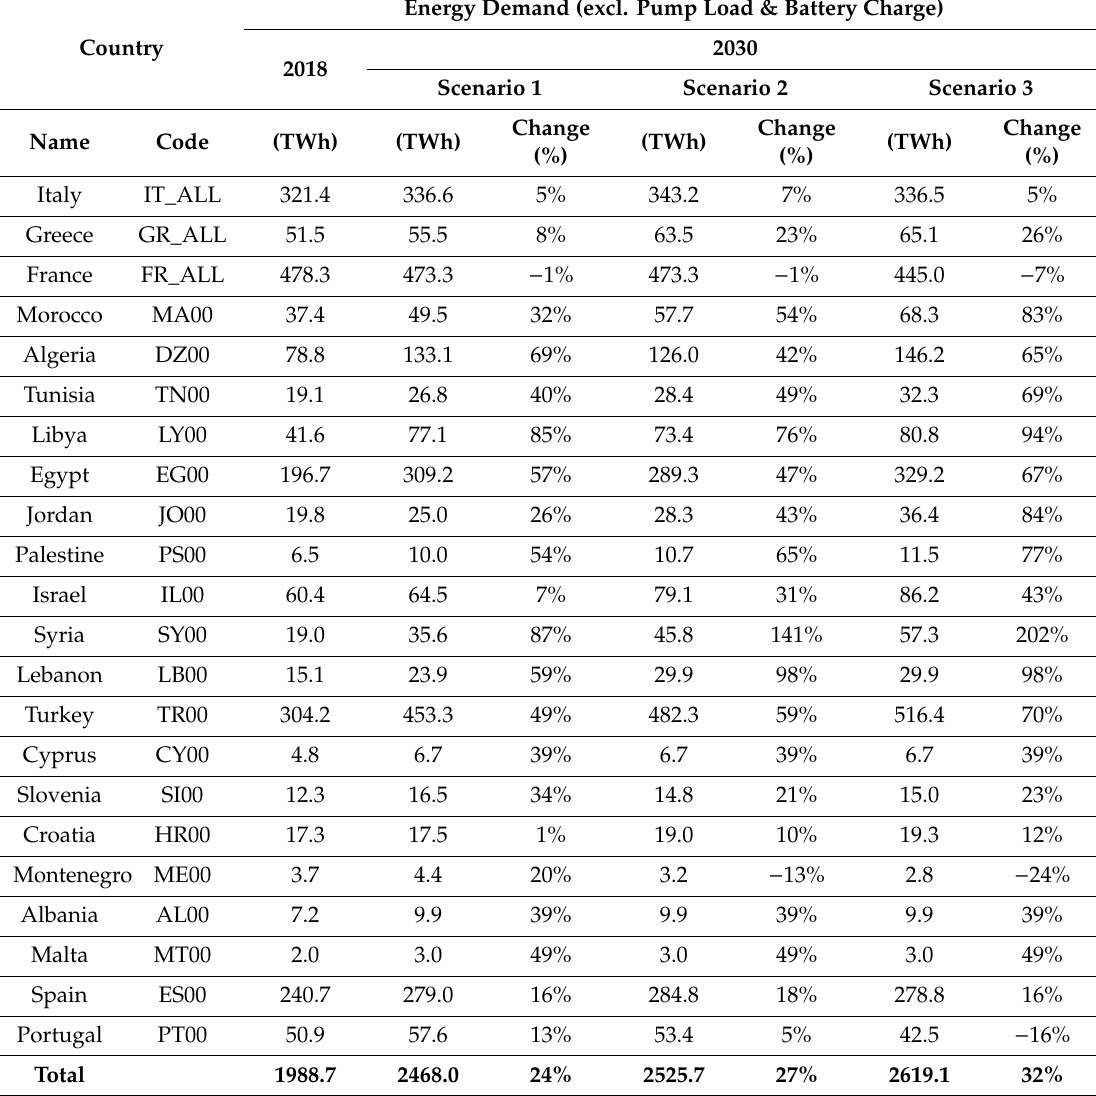
Table 1. Energy demand for 2018 and predictions for Scenario 1, 2 and